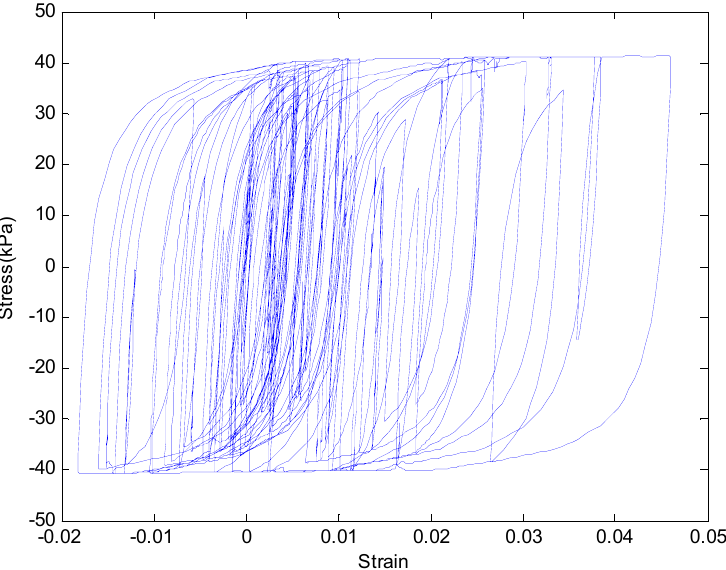
Figure 3. Stress–strain curve of soil under seismic loading.